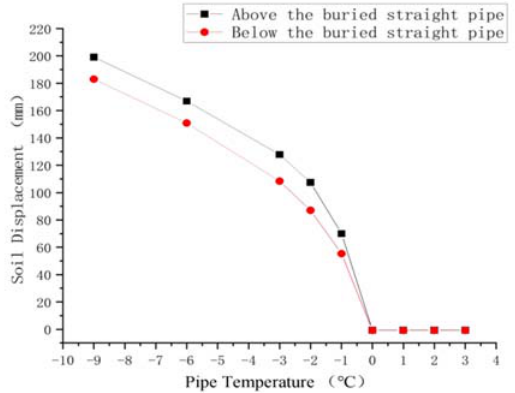
Figure 20. Frost heave displacement diagram of soil near the inlet ascending pipe with pipe temper- ature variation.